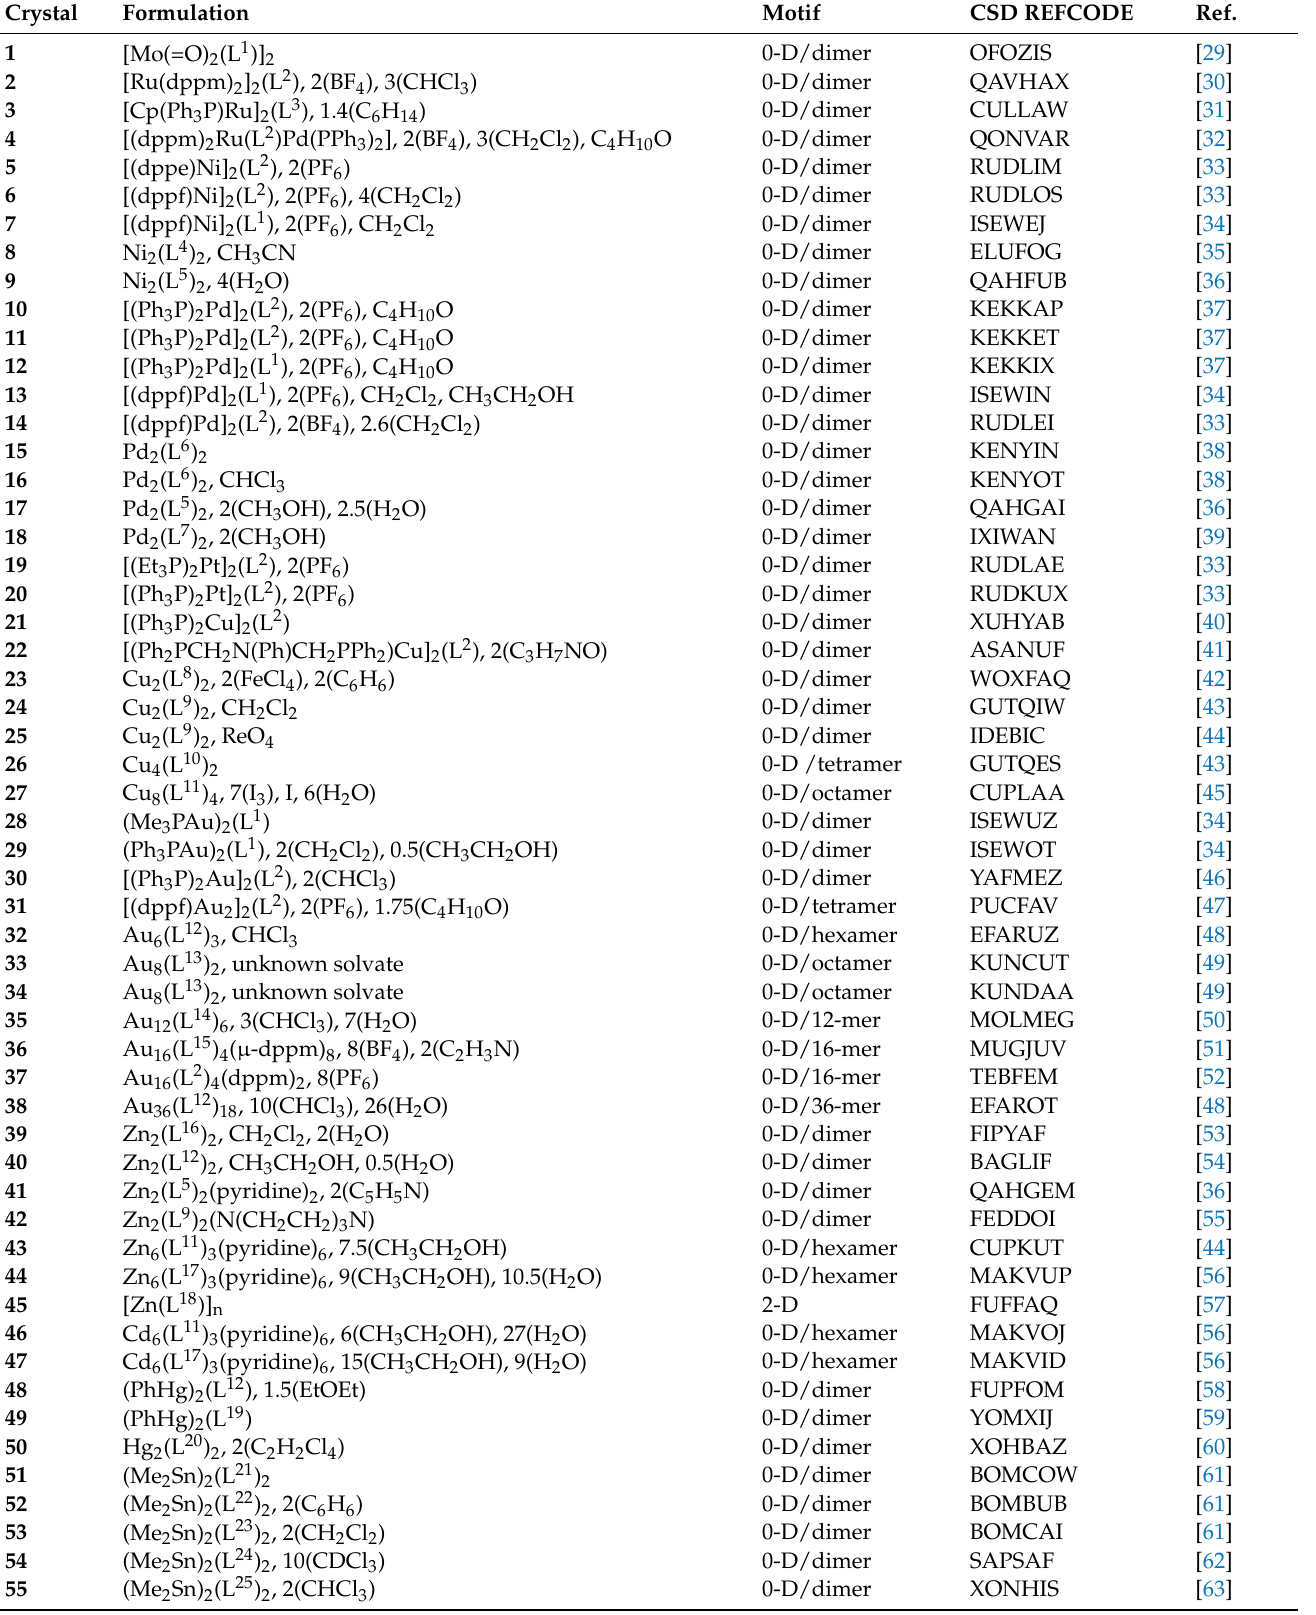
Table 1. Summary of structures 1 – 102 covered in this bibliographic